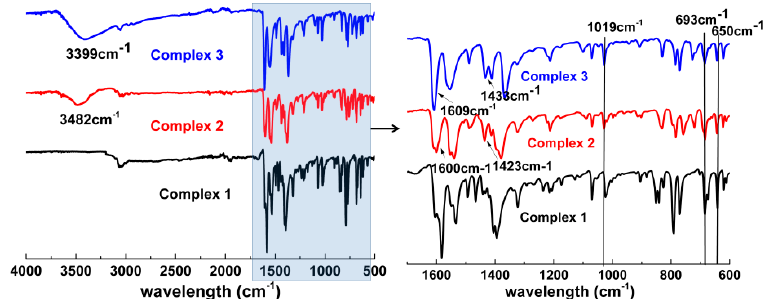
Figure 5. Comparison of FT-IR spectrum of complexes 1 , 2 , and 3 .